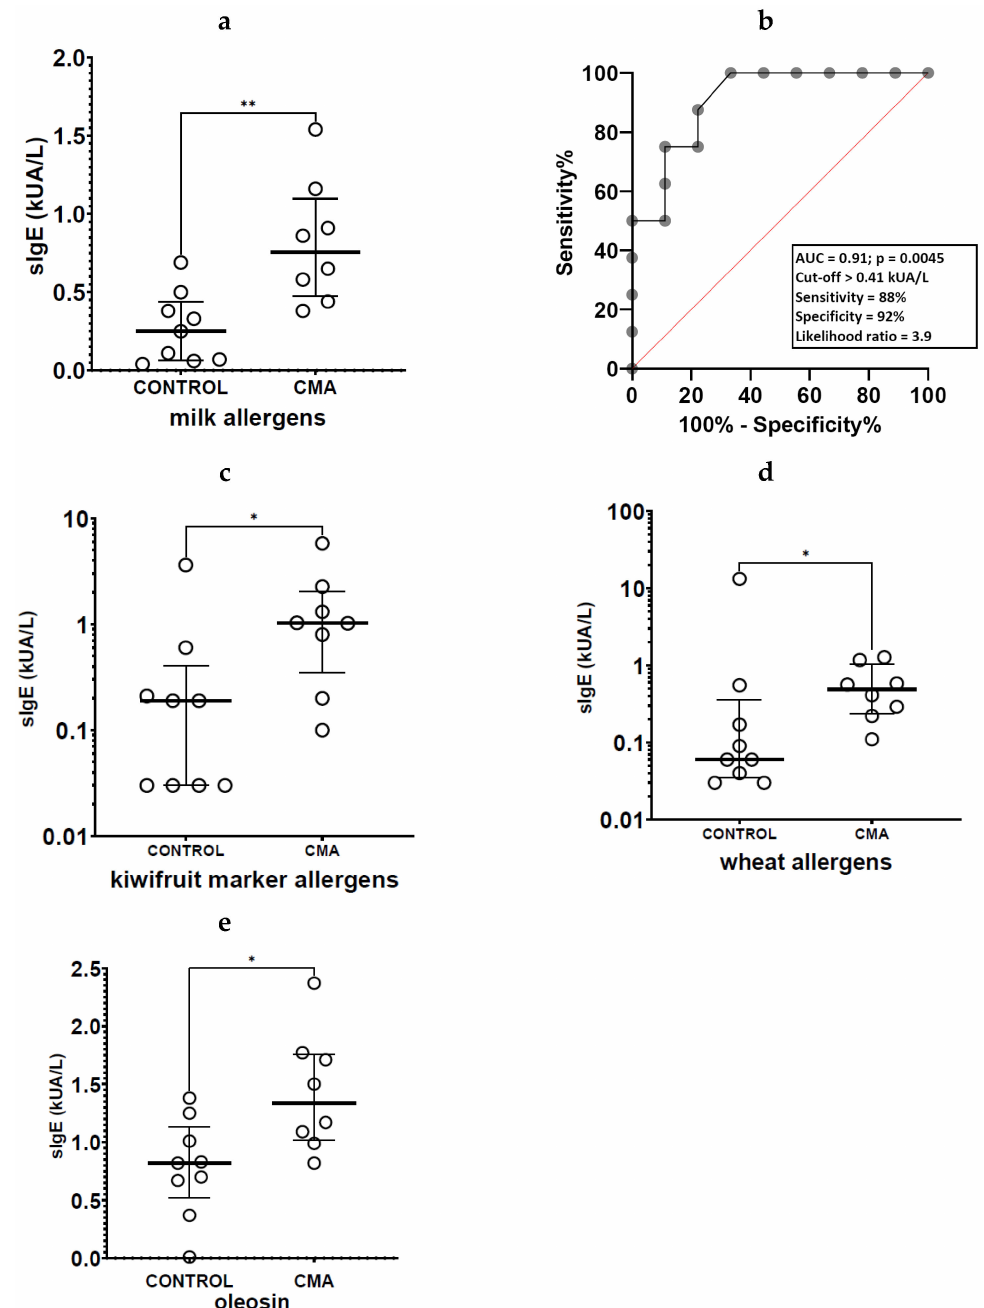
Figure 4. Levels of neonatal fecal sIgE directed to milk allergens and other common food allergens. ( a ) The levels of neonatal fecal sIgE to milk allergens are predictive of CMA during the 1st year of life ( p = 0.003); ( b ) An ROC analysis shows that a cut-off value of 0.41 kUA/L for neonatal fecal sIgE to milk allergens predicts CMA during the 1st year of life with a sensitivity of 88% (CI95%: 53–99%) and a specificity of 78% (CI95%: 45–96%); p = 0.0045; ( c – e ) The levels of neonatal fecal sIgE to kiwifruit marker allergens ( p 0.02), wheat allergens ( p = 0.03), and oleosin ( p = 0.02) are higher in patients who developed CMA during the 1st year of life compared to the controls who did not. Asterisks indicate significant differences * p < 0.05; ** p <